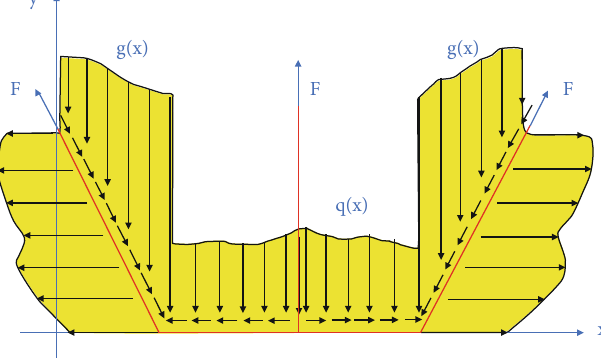
Figure 19: Mechanical model of support structure in stage